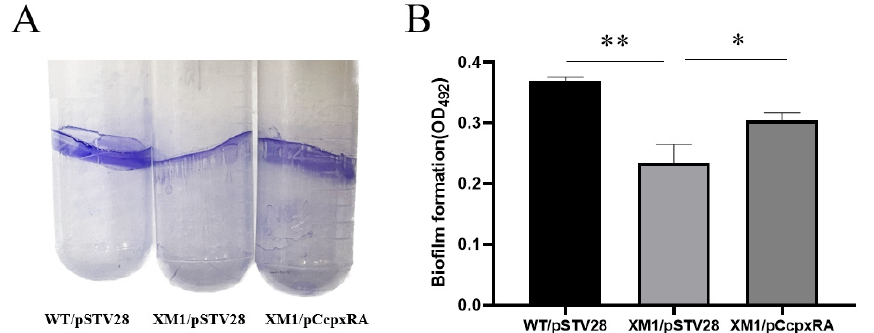
Figure 2. WT/pSTV28, XM1/pSTV28, and XM1/pC cpxRA biofilm formation ability detection. ( A ) Image of biofilm formation on the wall of a polystyrene tube. ( B ) Cells adhering to polystyrene tubes, 0.1% crystal violet staining, 33% glacial acetic acid dissolving, and measuring optical density at 492 nm. Error bars indicate SD; * represents p < 0.05, ** represents p < 0.01.